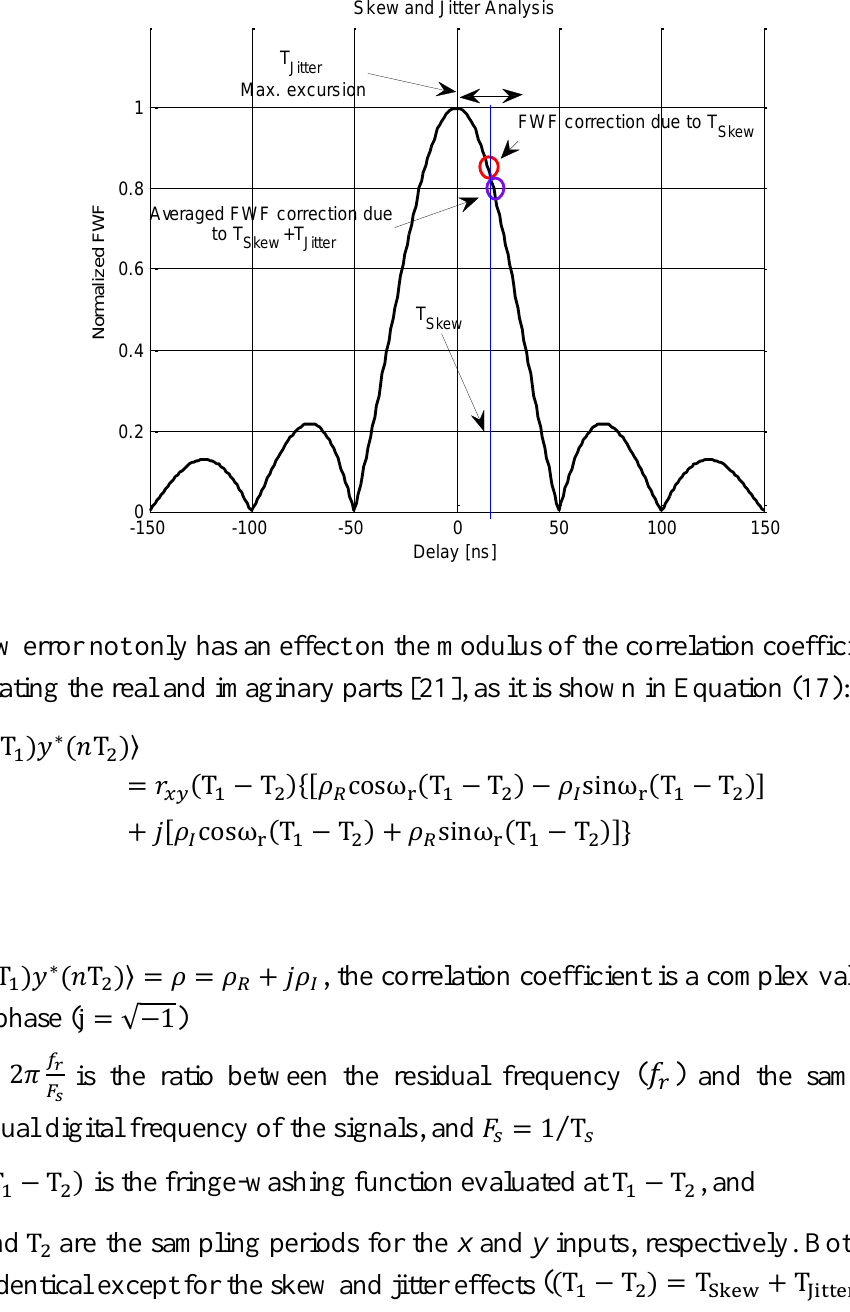
is its fluctuations due to clock Jitter